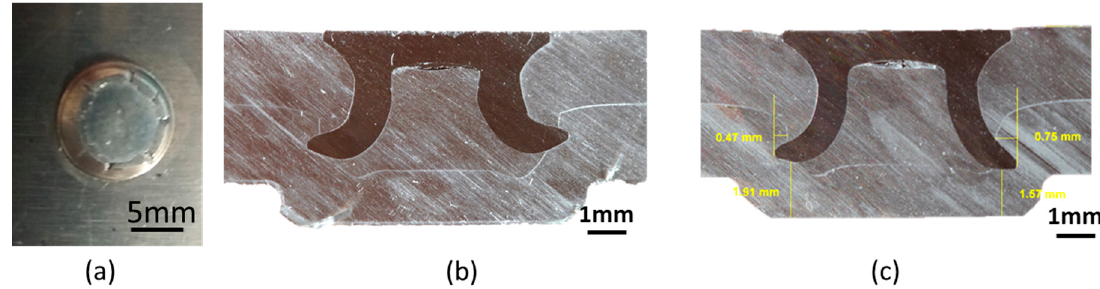
Figure 3. Different failed joints that could not fulfill the requirements of an acceptable joint: ( a ) surface cracks on the bottom joint performed using ϕ 9 mm die with a depth of 1.8 mm and a rivet with a length of 7 mm and hardness of 420 Hv with a velocity of 270 mm/s ; ( b ) over-flowing of the rivet (large deformed rivet diameter) of a joint using ϕ 10 mm die with the depth of 1.2 mm and a rivet with a length of 7 mm and hardness of 420 Hv with a velocity of 360 mm/s ; ( c ) asymmetrically deformed rivet appearing after a joint using ϕ 10 mm die with a depth of 1.4 mm and a rivet with a length of 6.5 mm and hardness of 440 Hv with a velocity of 350 mm/s .